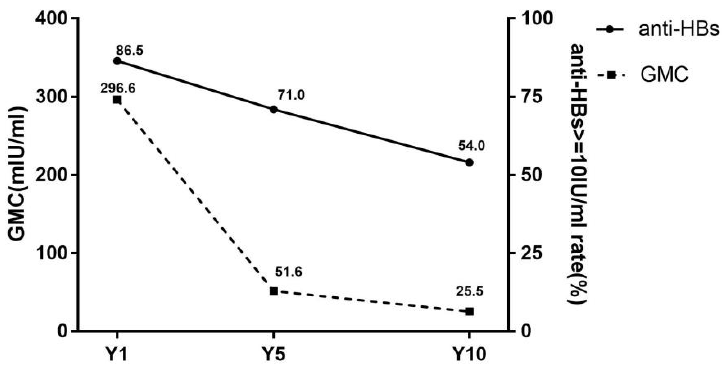
Figure 1. Seroprotection rates and GMC of subjects in different groups. anti ‐ HBs, antibody against hepatitis B virus surface antigen; GMC, geometric mean concentration of anti ‐ HBs; Y1, the group for 1 year after the full course of vaccination; Y5, the group for 5 years after the full course of vac ‐ cination; Y10, the group for 10 years after the full course of vaccination. Seroprotection rates repre ‐ sentation of the anti ‐ HBs positive rates (anti ‐ HBs ≥ 10 mIU/mL).